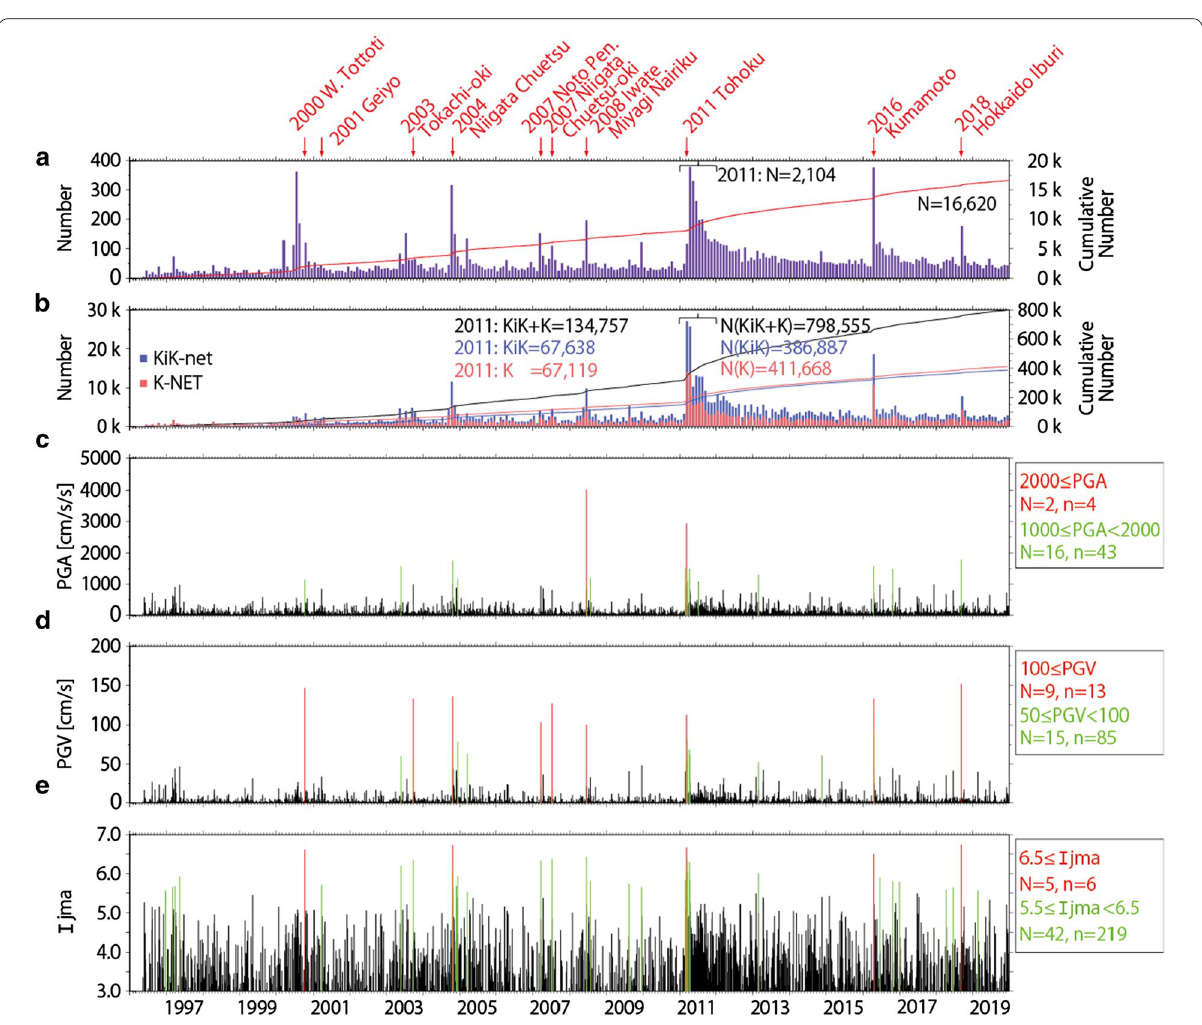
Fig. 10 a Monthly and cumulative numbers of earthquake events in the K-NET and KiK-net data archive up to the end of 2019. The histogram and line represent the monthly and cumulative numbers, respectively. b Monthly and cumulative numbers of the strong motion records in the K-NET and KiK-net data archives. The red, blue, and black lines represent the cumulative numbers of records for K-NET, KiK-net, and their total, respectively. c Temporal distribution of PGA in the K-NET and KiK-net data archives. The red, green, and black lines represent the PGA values of 2000 cm/s/s or larger, 1000 cm/s/s or larger but lower than 2000 cm/s/s, and lower than 1000 cm/s/s, respectively. N and n denote the numbers of earthquakes and the records satisfying the criterion, respectively. d Temporal distribution of PGV in the K-NET and KiK-net data archives. The red, green, and black lines represent the PGV values of 100 cm/s or larger, 50 cm/s or larger but lower than 100 cm/s, and lower than 50 cm/s, respectively. N and n denote the numbers of earthquakes and the records satisfying the criterion, respectively. e Temporal distribution of the JMA seismic intensity (Ijma) in the K-NET and KiK-net data archives. Red, green, and black lines represent Ijma 6.5 or larger, 5.5 or larger but lower than 6.5, and lower than 5.5, respectively. N and n denote the numbers of earthquakes and the records satisfying the criterion,